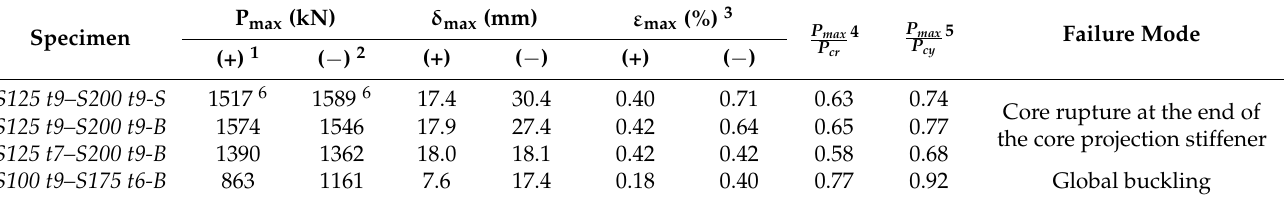
Figure 13. Typical core strain distribution: ( a ) square specimens; ( b ) circular specimens. Table 5. Square specimens test